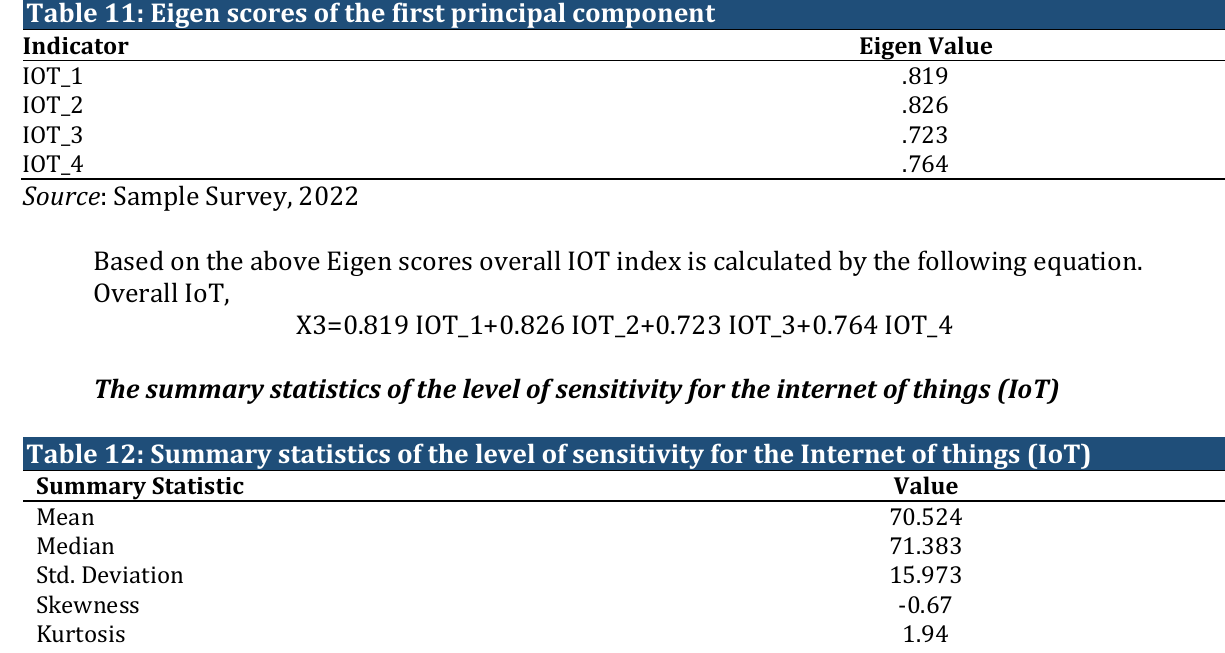
Table 11: Eigen scores of the first principal component Indicator